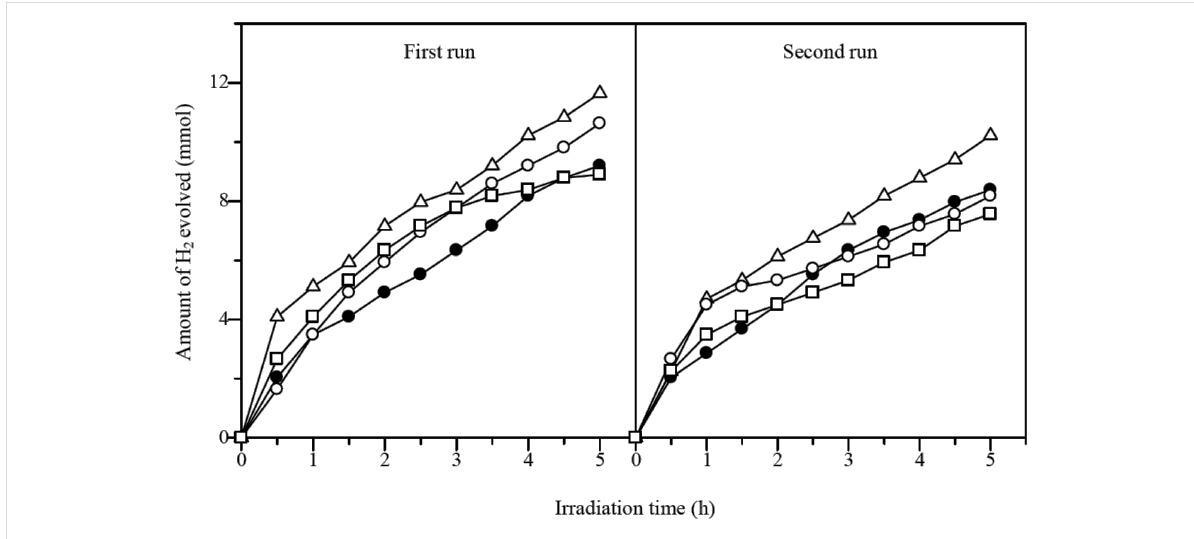
Figure 9: Photocatalytic hydrogen evolution on Cd 0.1 Zn 0.9 S (filled circles), Ag(0.01)-doped Cd 0.1 Zn 0.9 S (empty triangles), Ag(0.03)-doped Cd 0.1 Zn 0.9 S (empty circles), and Ag(0.05)-doped Cd 0.1 Zn 0.9 S (empty squares) prepared by the co-precipitation method under visible-light